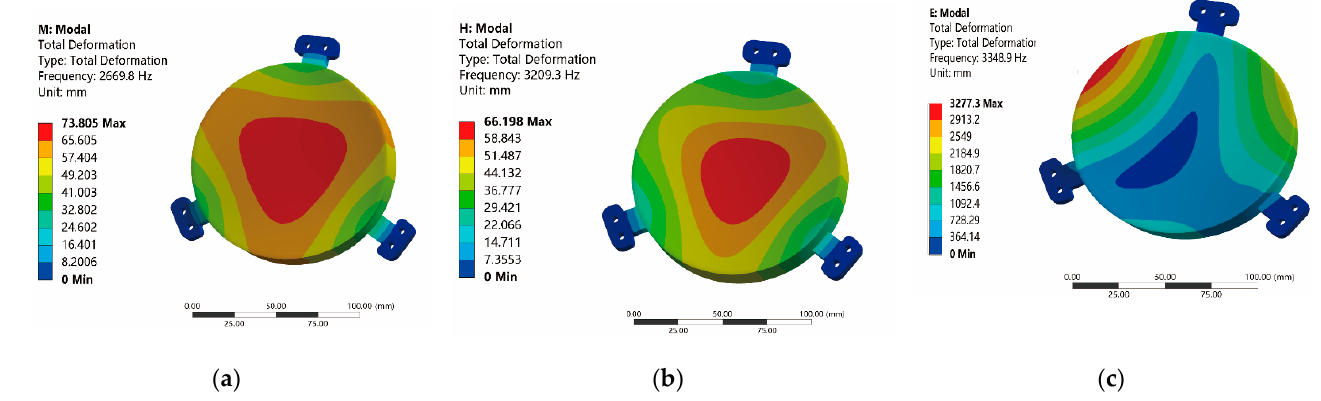
Figure 10. Results of first-order modal: ( a ) honeycomb mirror; ( b ) 2.5D-Voronoi mirror; and ( c ) 3D-Voronoi mirror.